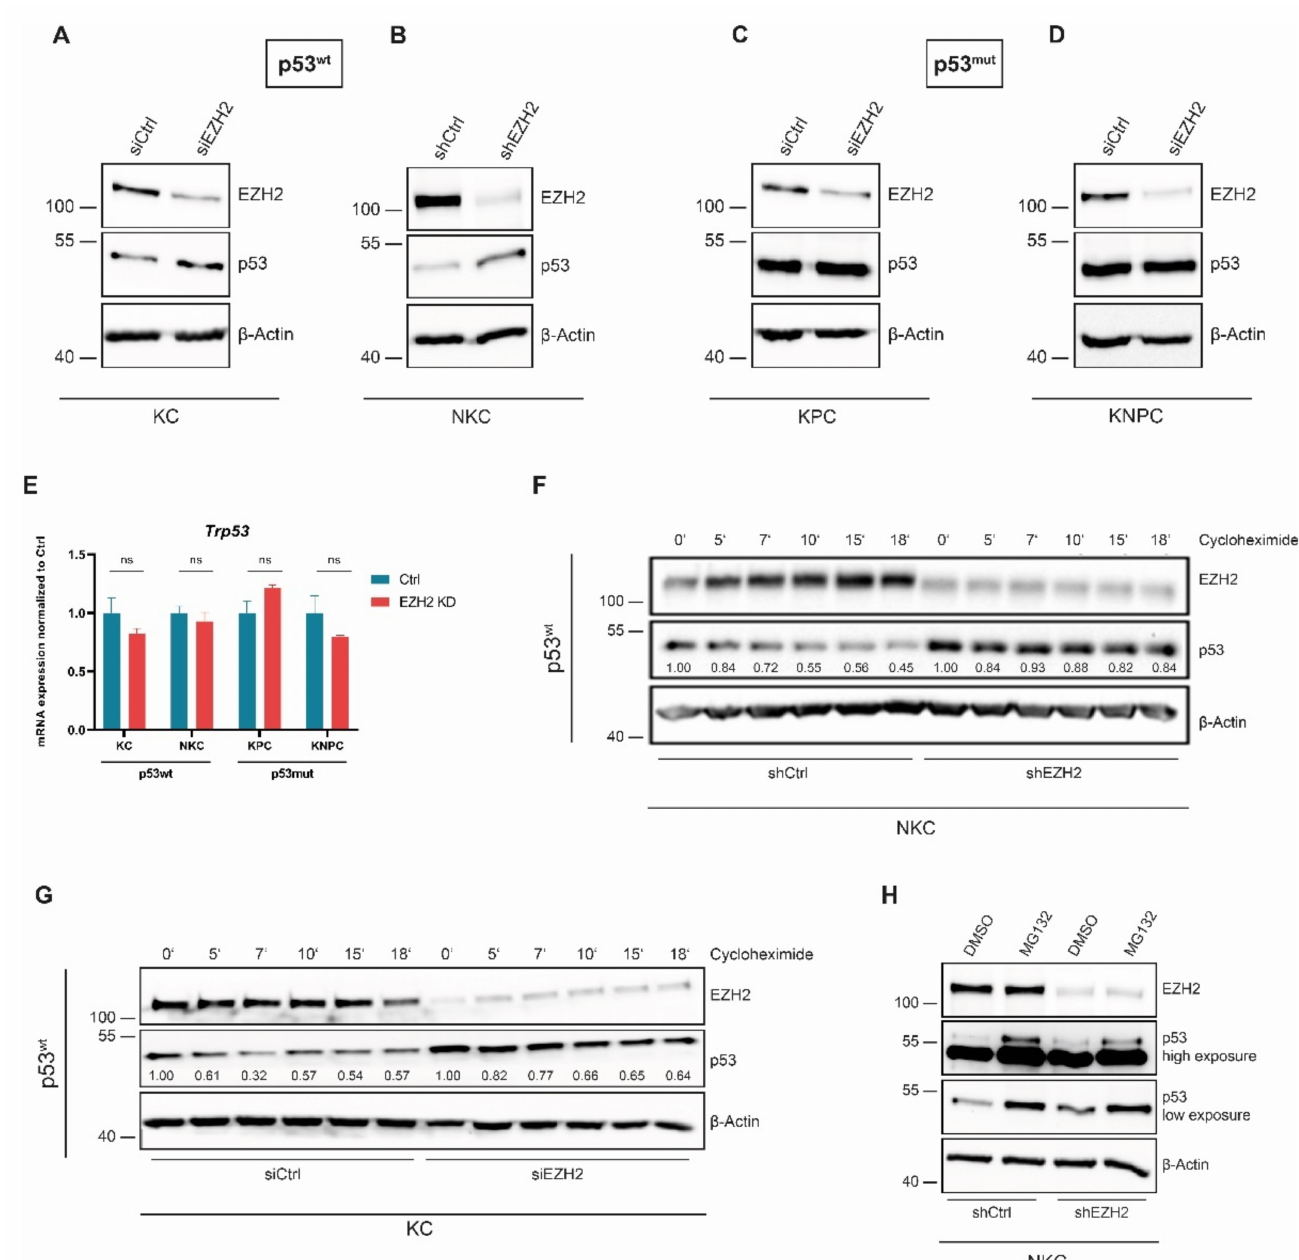
Figure 4. EZH2 controls p53wt on a post-translational level. ( A – E ) Western blot analysis ( A – D ) and qRT-PCR analysis ( n = 3) € in the indicated p53wt and p53mut cells upon knockdown of EZH2. Values represent mean ± SD. Significance was determined by Student’s t -test; ns, non-significant. ( F , G ) Western blot analysis in the indicated p53wt cells upon short-term treatment (0–18 min) with cycloheximide to block translation and visualize the difference in p53 half-life between EZH2- proficient and -deficient cells. Densitometric quantification of p53 detection was performed using ImageJ and is revealed under the respective band. The p53 band intensities determined at the